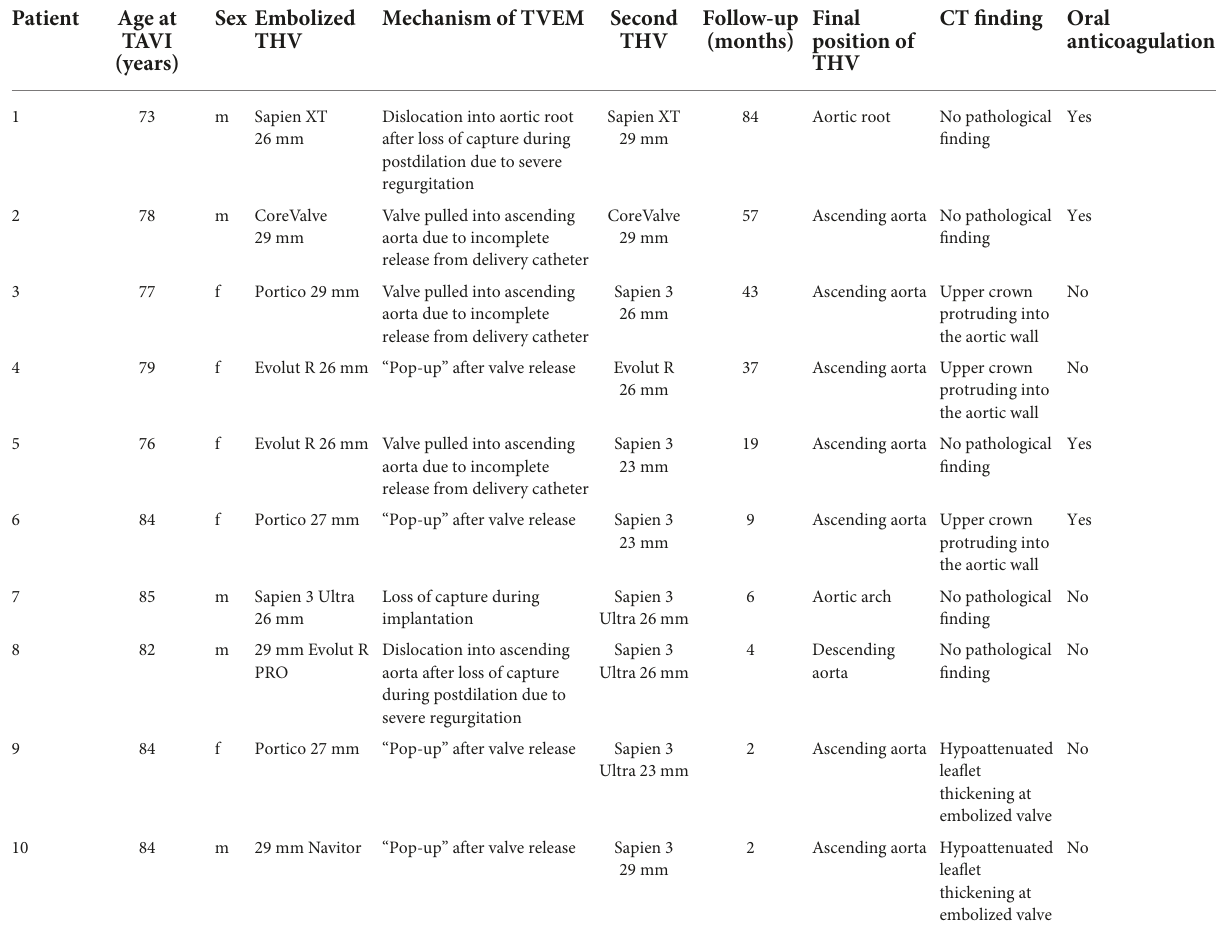
TABLE 5 Overview of all patients examined by computed tomography